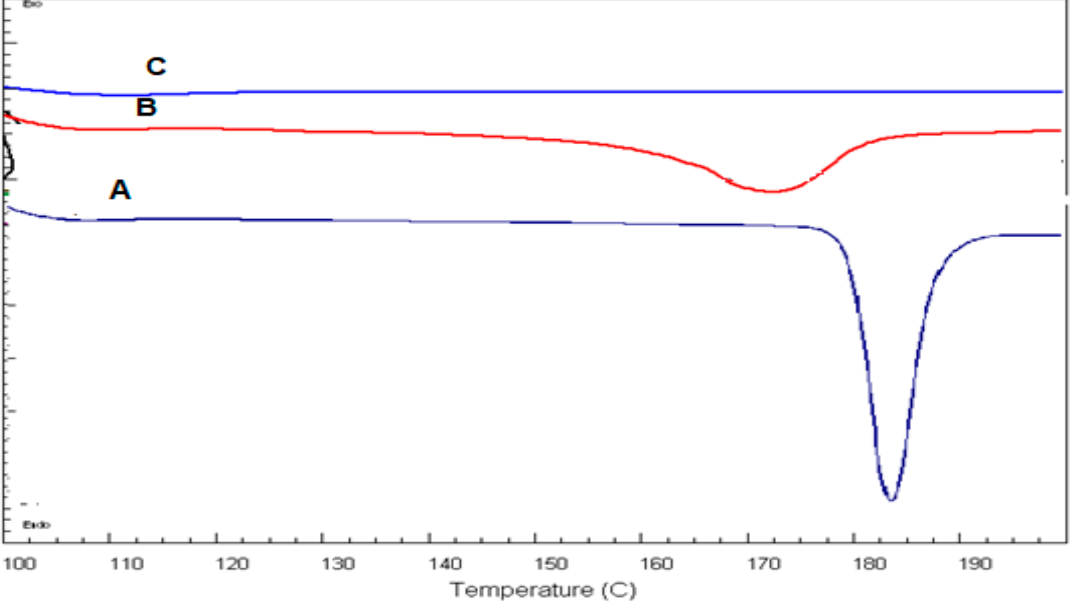
Figure 5. DSC thermograms of ( A ): pure ROS, ( B ): lecithin, span 60, and ROS physical mixture, ( C ): the optimum formula.